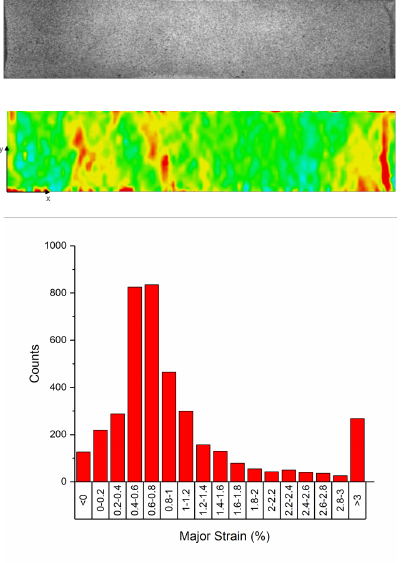
Figure 1. DIC analysis of a tensile test